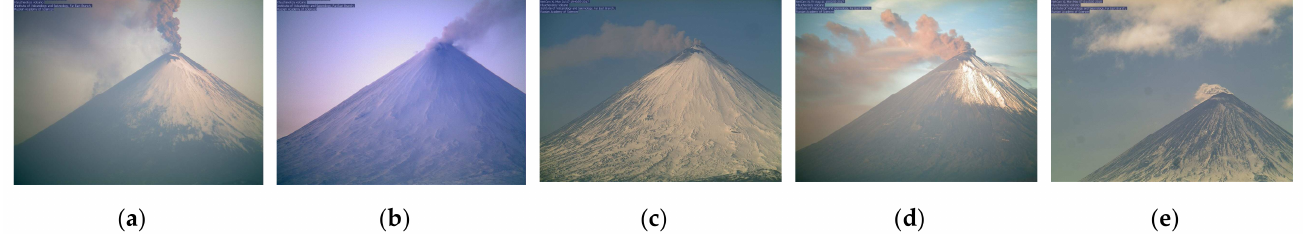
Figure 2. Examples of region of interest shift for different observation periods of Klyuchevskoy volcano: ( a ) 6 July 2016; ( b ) 19 December 2016; ( c ) 17 July 2017; ( d ) 11 August 2017; ( e ) 7 May